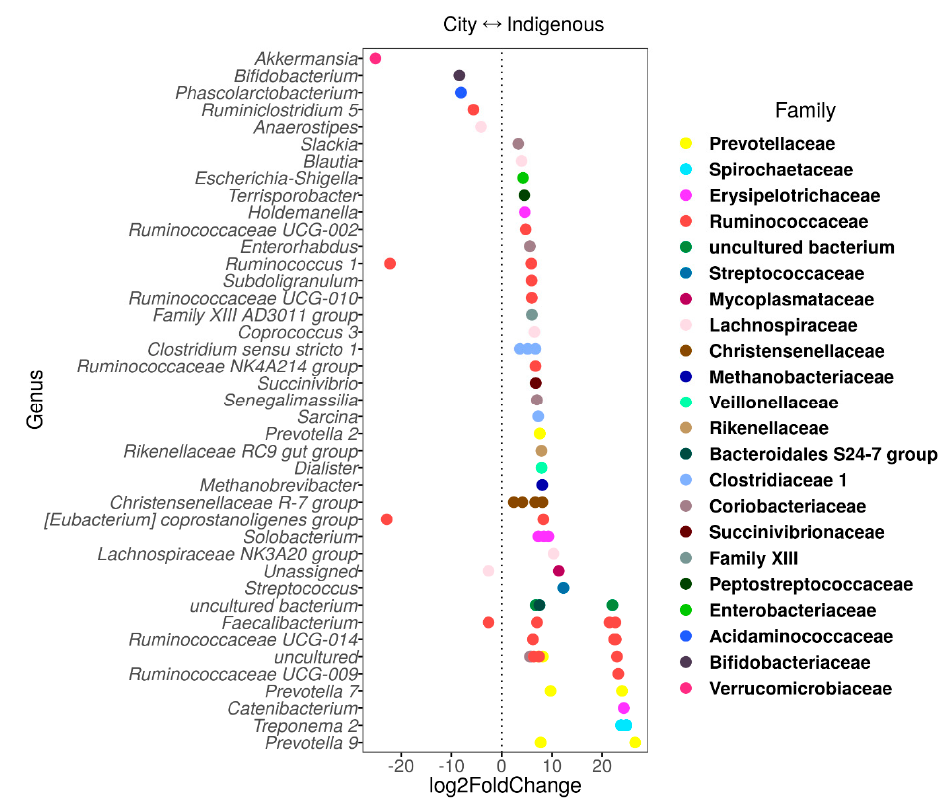
Figure 4. Log2 fold-change analysis of the combined children GM from México City (City) and indigenous (Me´phaa) communities. Fecal-prokaryotic ASVs grouped by genus and colored by family (legends). Log2 fold-change values indicate the strength and direction of the association to City (<0) and Me’phaa (>0) children. Genus observed in this figure were statistically significantly different between locations at p < 0.01 corrected with the FDR (false discovery rate) method.